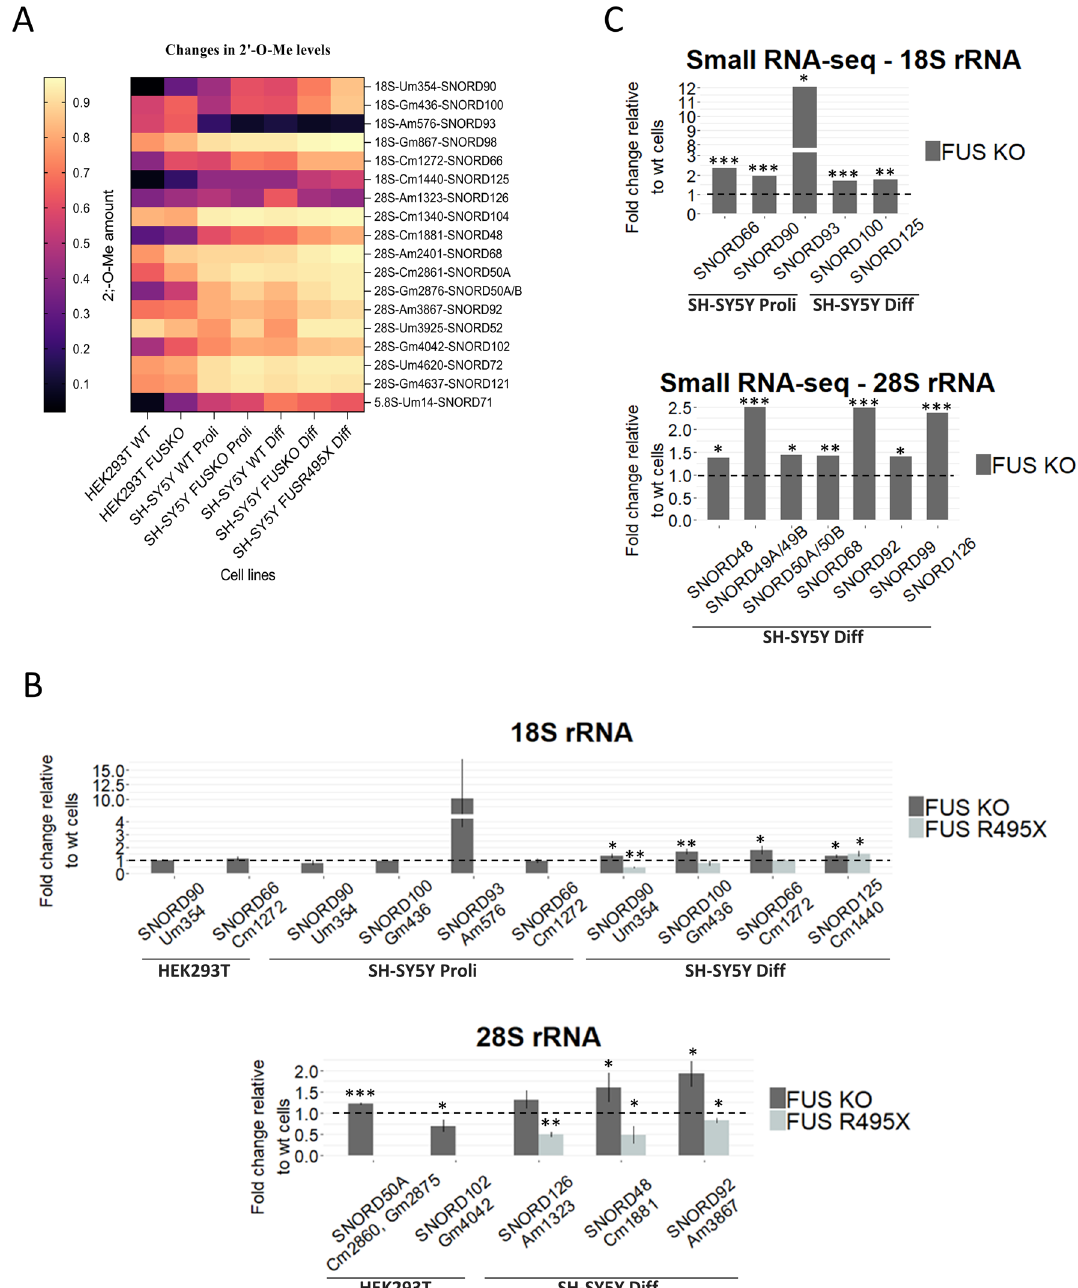
Figure 2. Differential heatmap for variations in 2’-O-Me levels in all cells analyzed, representing the mean of three biological replicates from each cell line ( A ). Heatmap was generated using Graphpad Prism 8.4.2 (https:// www. graph pad. com/ scien tific- softw are/ prism/). Heatmap represents sites with at least a 10% (0.1) difference in 2’-O-Me between cell types. RT-qPCR analysis of relative expression levels of selected C/D box snoRNAs that guide methylation of residues in 18S rRNA and 28S rRNA ( B ). The values represent the mean and error bars indicate the SD of three biological replicates from each cell line. HEK293T FUS KO cells, proliferating (Proli) SH-SY5Y FUS KO, differentiated (Diff) SH-SY5Y FUS KO cells, and SH-SY5Y FUS R495X cells were compared to WT cells, respectively. P values were calculated using Student’s t -test, and the statistical significance is defined as follows: * P ≤ 0.05; ** P ≤ 0.01; *** P ≤ 0.001. Small RNA-seq results for some of the differentially expressed C/D box snoRNAs identified by DEseq2 analysis in Proli and Diff SH-SY5Y FUS KO cells and presented as relative fold change as compared to WT cells ( C ). *Padj ≤ 0.05; **Padj ≤ 0.01; ***Padj ≤